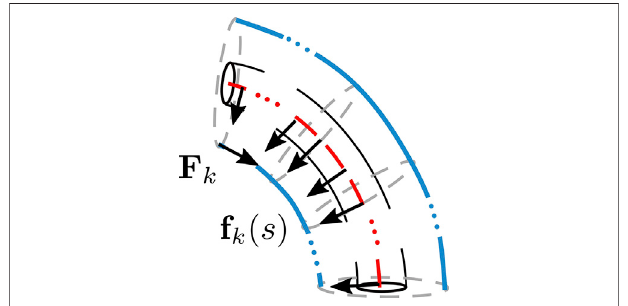
FIGURE 6 | Representation of uniformly distributed force f k ( s ) and tendon termination force F k exerted on the backbone, by assuming that tendon k follows a continuous path.